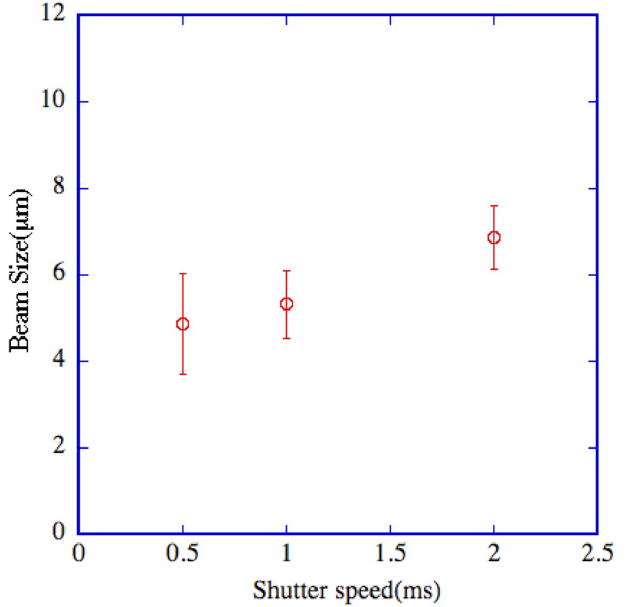
FIG. 8. (Color) Measured interferogram and fitting function.